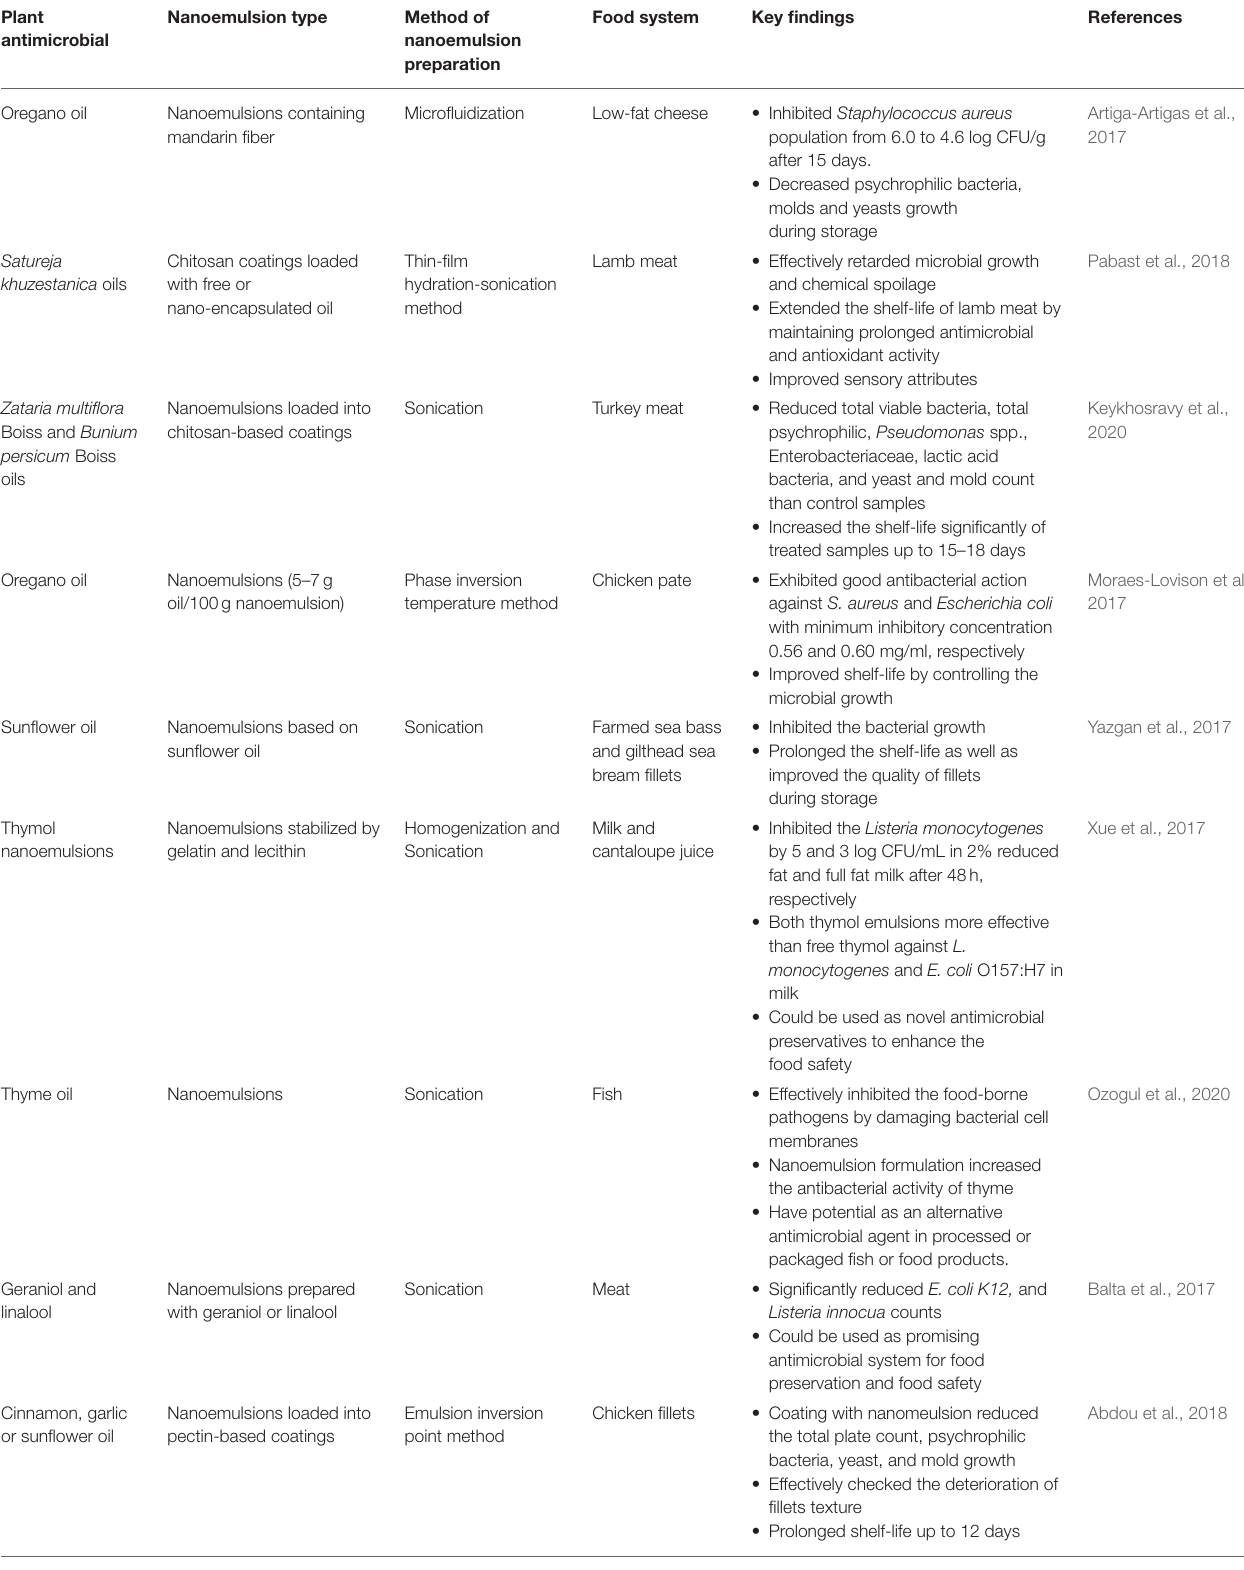
TABLE 3 | Delivery of various kinds of plant-based antimicrobials using nanoemulsions in different food